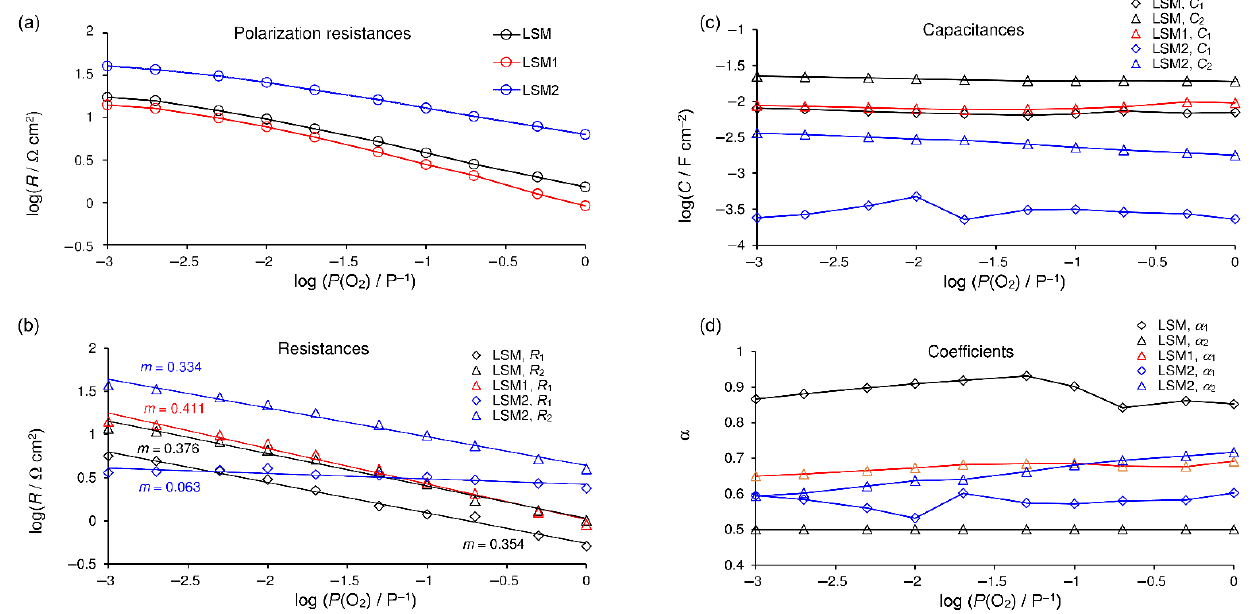
Figure 7. Relationships for spectra recorded at 800 ◦ C on oxygen partial pressure: ( a ) polarization resistance and results of fitting for separate processes: ( b )—resistances with trend lines and calculated m coefficients, ( c ) capacitances, and ( d ) parameters α . LSM electrode—black; LSM1—red; LSM2—blue.